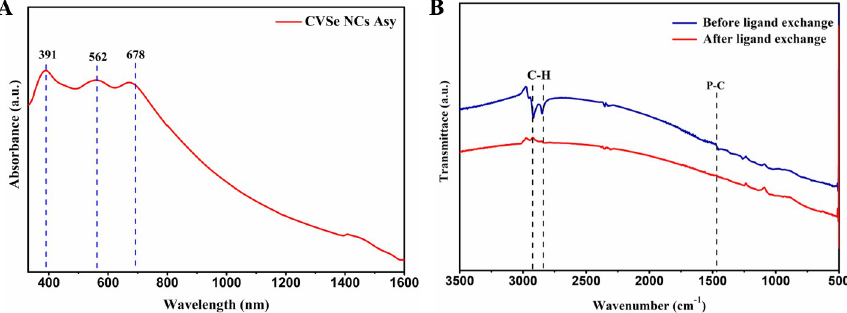
Fig 4. (A) UV-Vis-NIR spectra of the synthesized CVSe NCs in ethanol (B) FTIR spectra of the as-synthesized CVSe NCs (blue line) and CVSe with ligand exchange (red line).